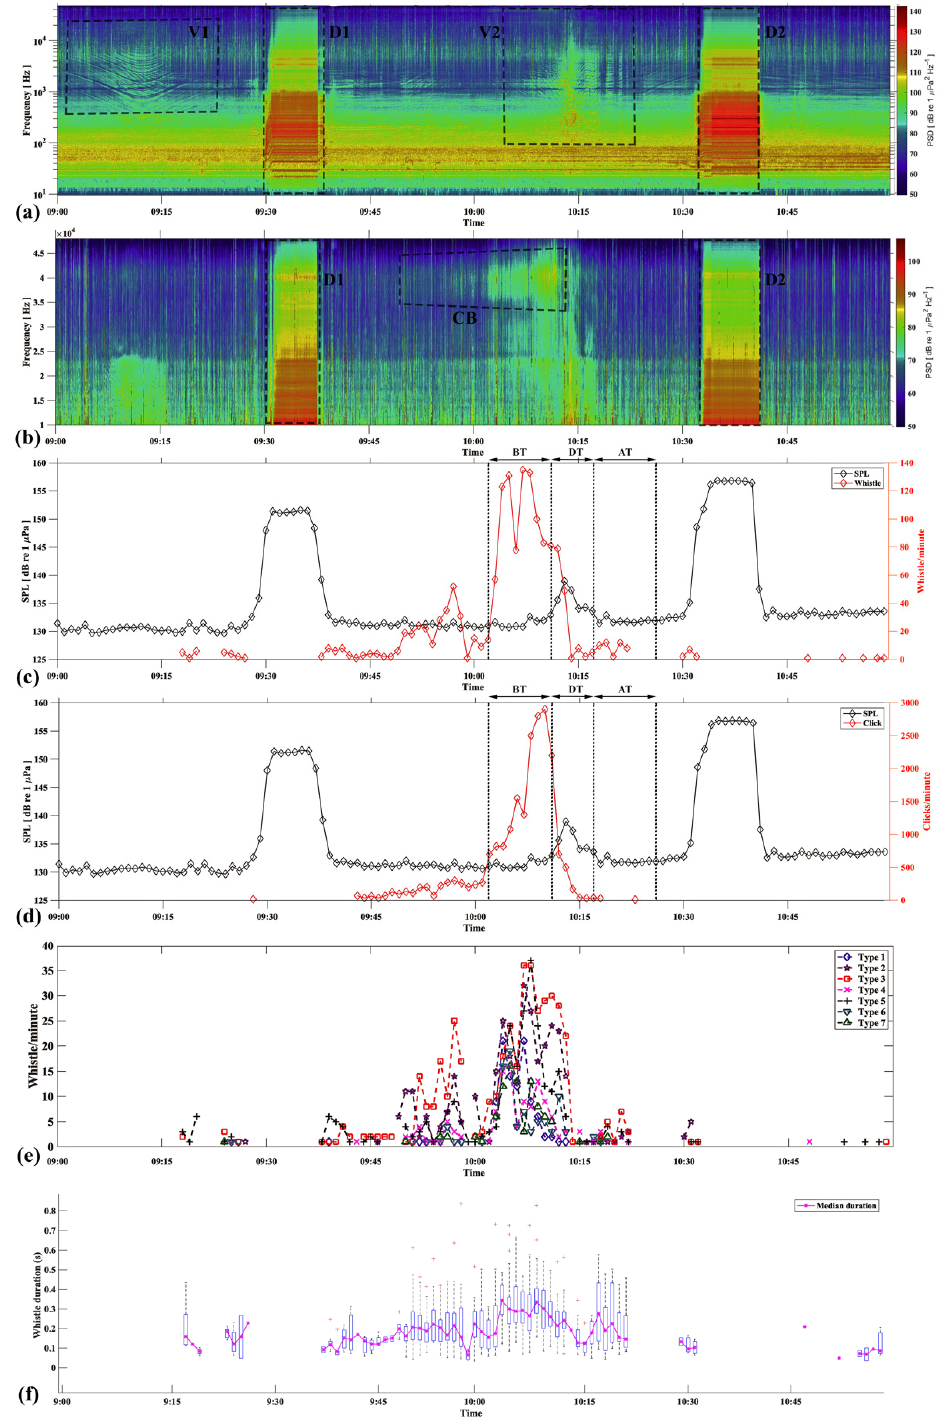
Figure 2. ( a , b ) Spectrograms in logarithmic (10–48 kHz) and linear (10–48 kHz) scale showing vessel transits (V1 and V2), dredging (D1 and D2), and click burst (CB). ( c , d ) Comparison of the sound pressure levels (SPL)/minute (Left axis) with the whistle/minute and the click/minute (Right axis); vessel transit is shown in the graph and is divided into before transit (BT), during transit (DT), and after transit (AT). ( e , f ) Variation in whistle types and duration during the two hours (Box plot: cen ‐ tral red mark represents the median, and box limits show the 25th and 75th percentiles, whisker extremes are the maximum and minimum values, and ‘+’ represents outliers).